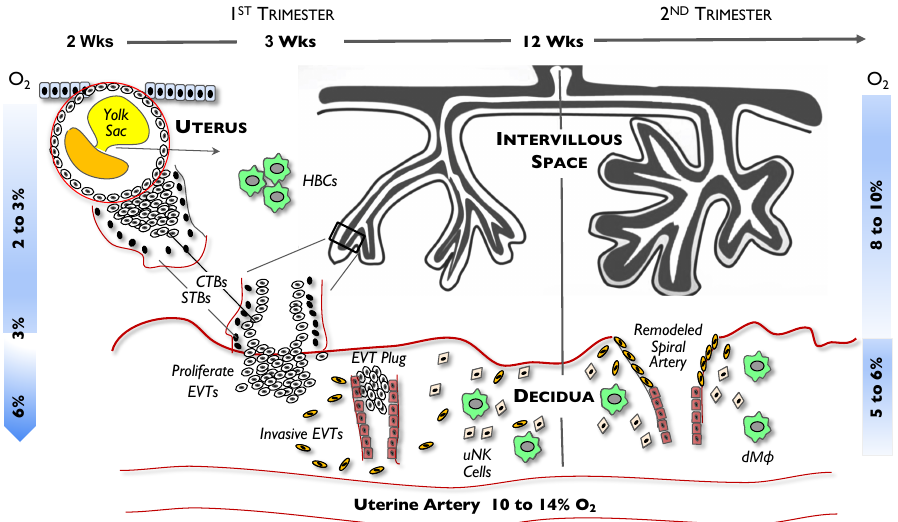
Figure 1. Schematic illustrating placental development—from blastocyst implantation to spiral artery remodeling and villous formation. Different events, such as proliferation of cytotrophoblast (CTBs), differentiation of extravillous trophoblasts (EVTs), formation of the EVT plug in the spiral artery, formation of Hofbauer cells (HBCs), and remodeling of the spiral arteries are shown. The dramatic changes of O 2 levels in the villous region during the 1st trimester (2–3%) and 2nd trimester (8–10%) compared with the relatively constant O 2 levels in decidua (5–6%) are highlighted. uNK, uterine natural killer; dM φ , decidua macrophages; O 2 , oxygen. Reprinted with permission from Ref. [5]. Copyright 2008 Chang C-W, et